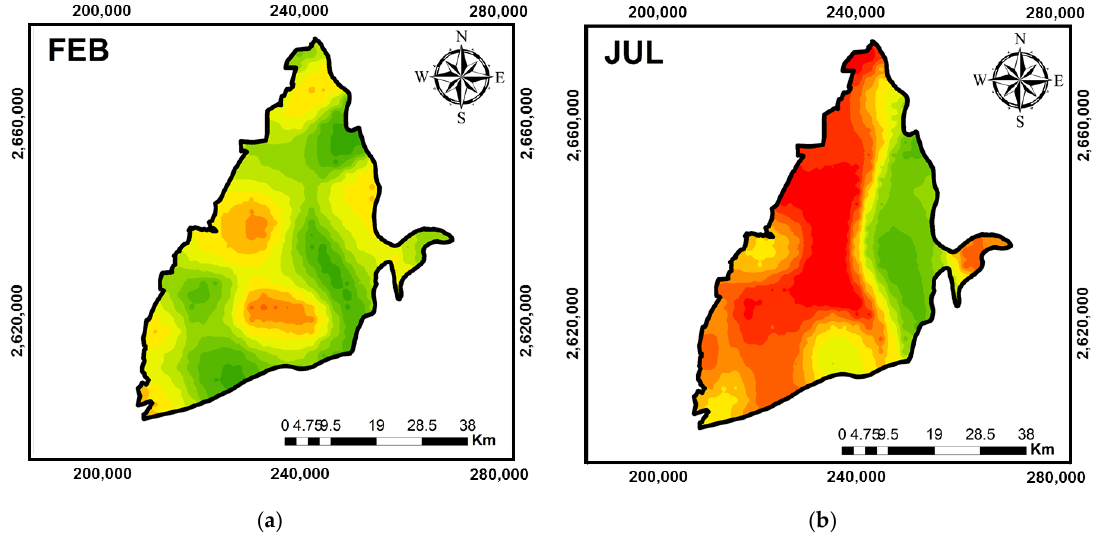
Figure 10. Monthly long-term averaged Pearson correlation distributions for GWL and GWR: ( a ) February and ( b ) July. The maps are consistent with the averaged dry and wet months. Note that the monthly maps are the accumulated results that account for the data obtained from 2006 to 2015.